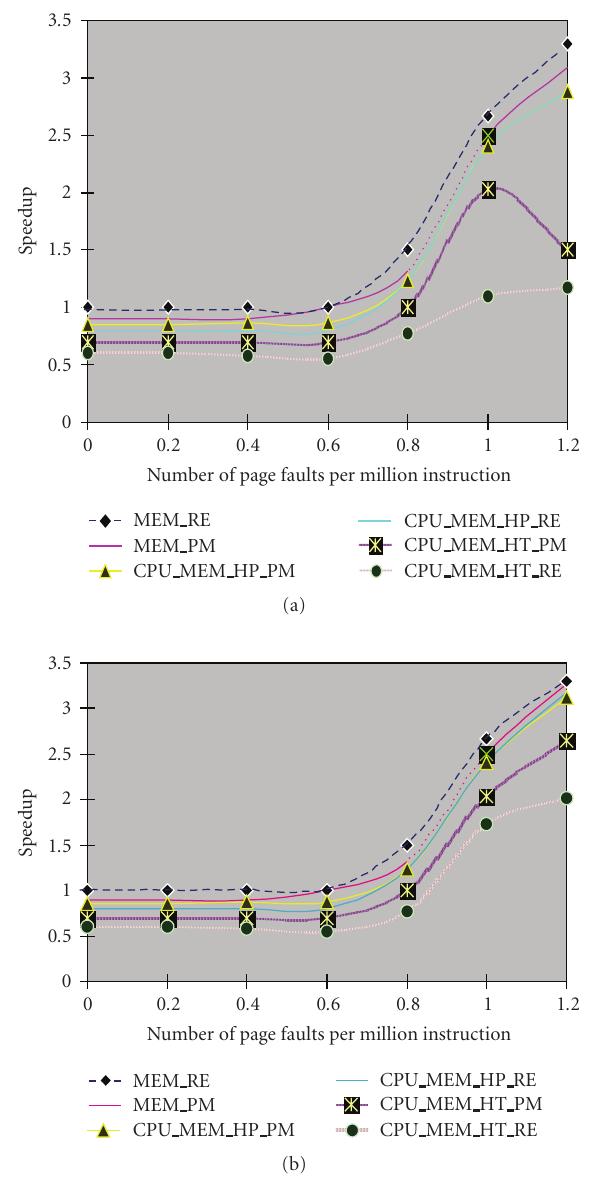
Figure 4: Speedups of the new load sharing policies over CPU PM as the page fault rate increases on “trace 0” with mean memory demand of 11 MB (a) and 12 MB (b).